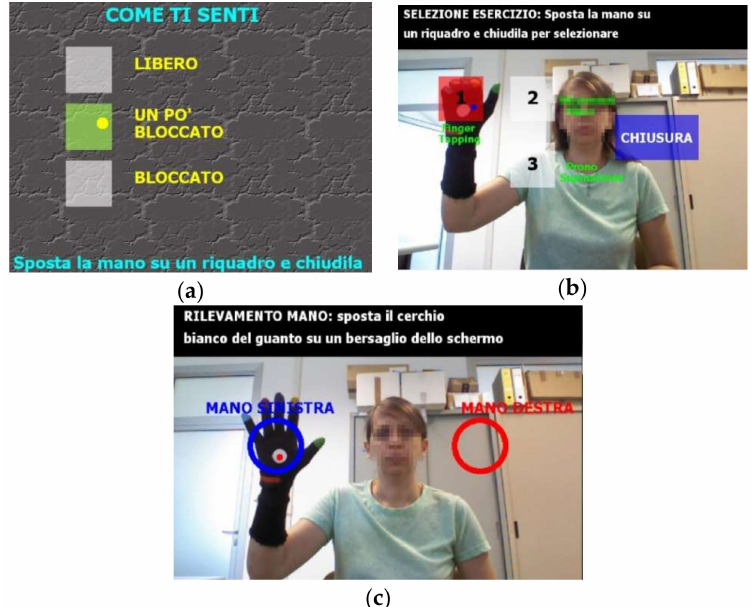
Figure 3. Human computer interface with natural gesture-based interaction: ( a ) patient’s input of the perceived motor impairment condition (low, medium, high) by hand positioning and closing on the menu items; ( b ) selection of the motor test (1, FT; 2, OC; 3, PS) by hand positioning and closing on the menu items ( c ) selection of the hand (SX, DX) involved in the motor test by positioning of the hand inside one of the circular